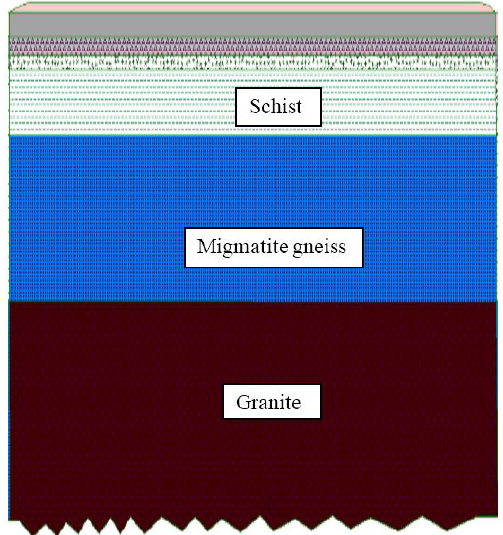
Figure 13. Improved sketch of the lithologic profile of Bétaré-Oya basin. The scale map is 2 / 1000.